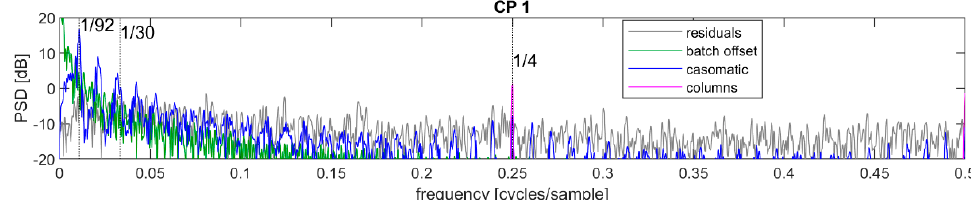
Figure 7. Power spectral density of the refined decomposed signal at control point CP1 for the 2022 data. The unit is in the logarithmic scale of decibel (dB) which implies a factor 10 for each increase by 10 dB. Table 1. Average (standard deviation) over sequences of variance of the dry matter signal and of its different components. An estimate of the “columns” contribution at CP2 is left out as the PSD sug- gested that this component is dominated by the noise level.